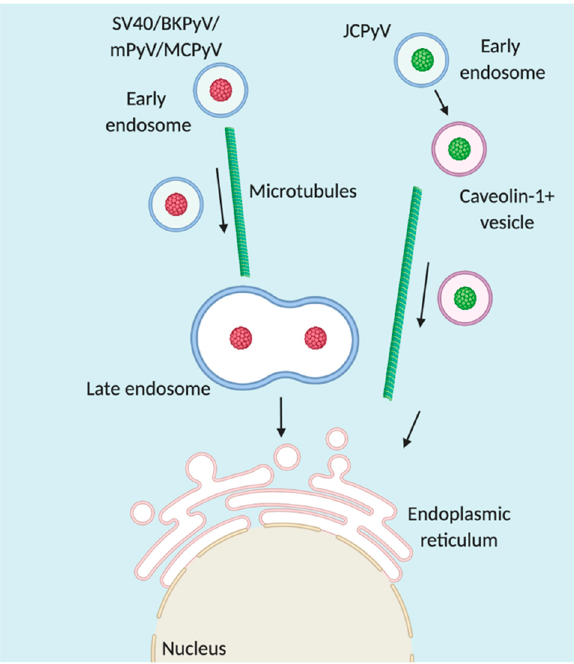
Figure 3. Intracellular trafficking of polyomaviruses. After internalization of polyomaviruses into the cell, they are targeted to the endoplasmic reticulum (ER). Upon internalization of SV40, BKPyV, mPyV, or MCPyV (red virion, collectively) into a pH neutral early endosome, the virus is delivered to the ER via microtubule-mediated transport and the late endosome / lysosome. Meanwhile, upon internalization of JCPyV (green virion) into an early endosome, association with caveolin-1 + vesicles occurs prior to retrograde transport to the ER. Figure created with BioRender.com.